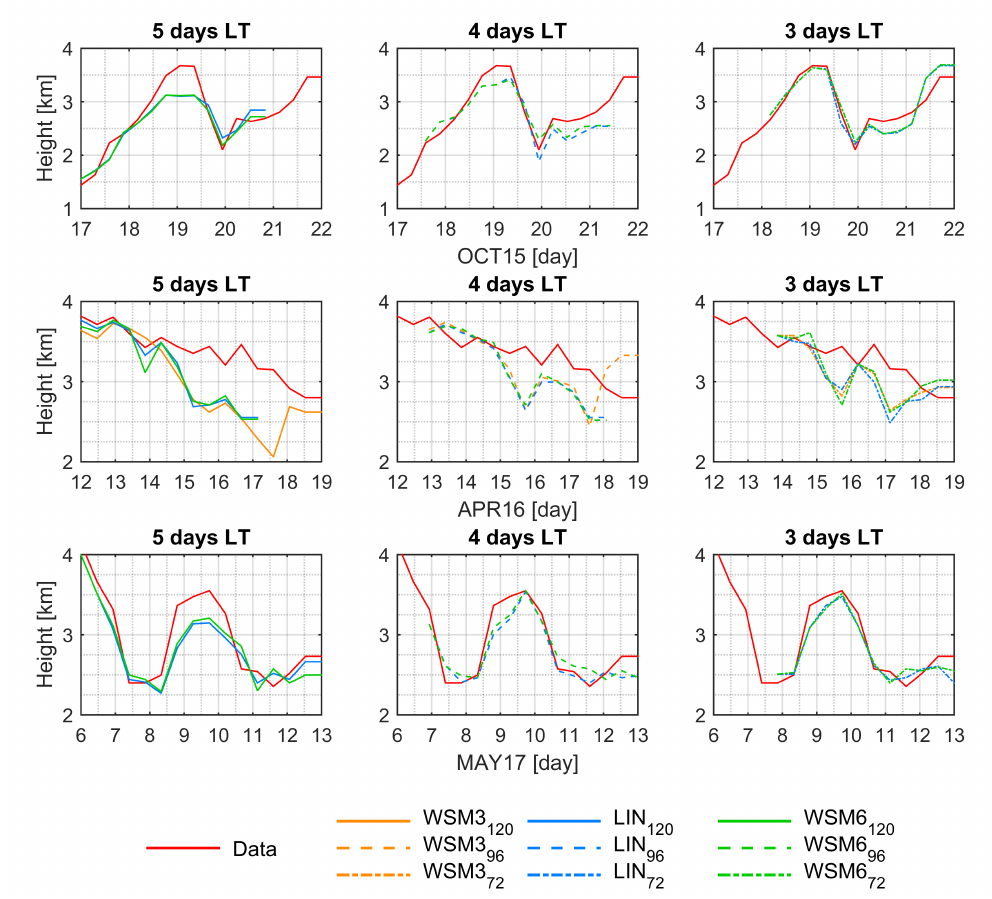
Figure 7. Freezing level height simulated with lead times (LT) of five ( left ), four ( center ) and three days ( right ), for OCT15 ( upper row), APR16 ( central row) and MAY17 ( lower row)